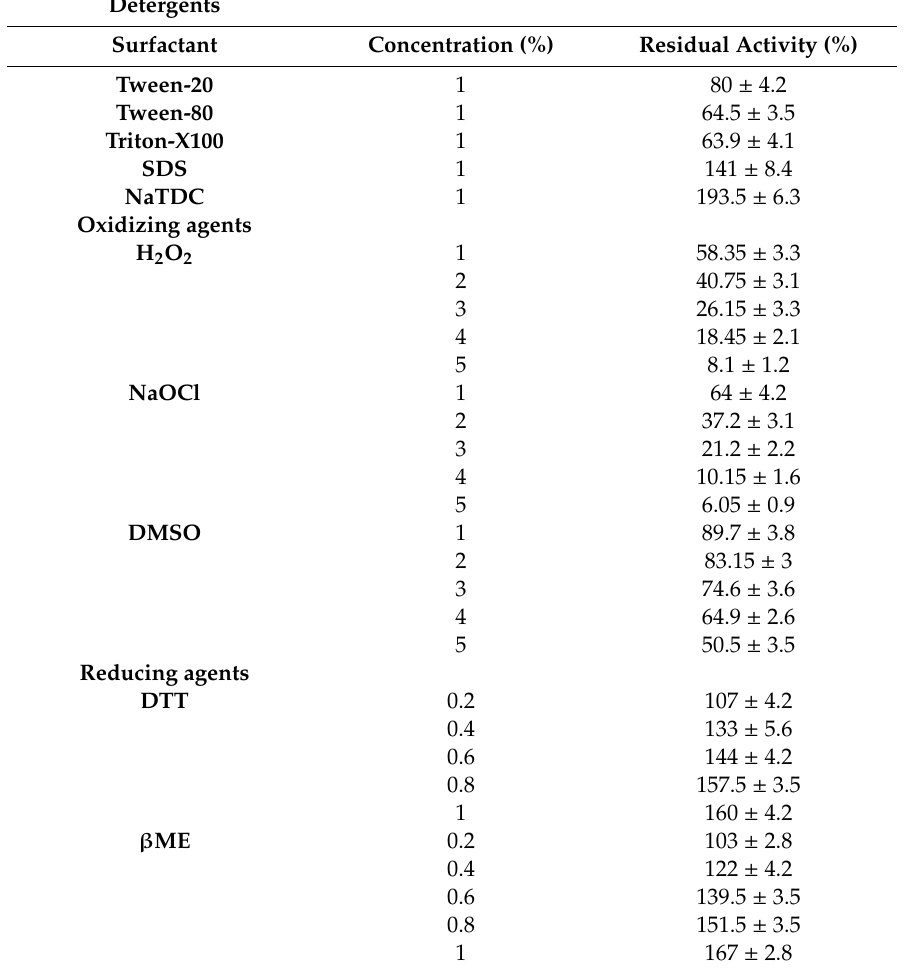
Table 3. E ff ects of surfactants and oxidizing / reducing agents on the stability of PDInhibitor